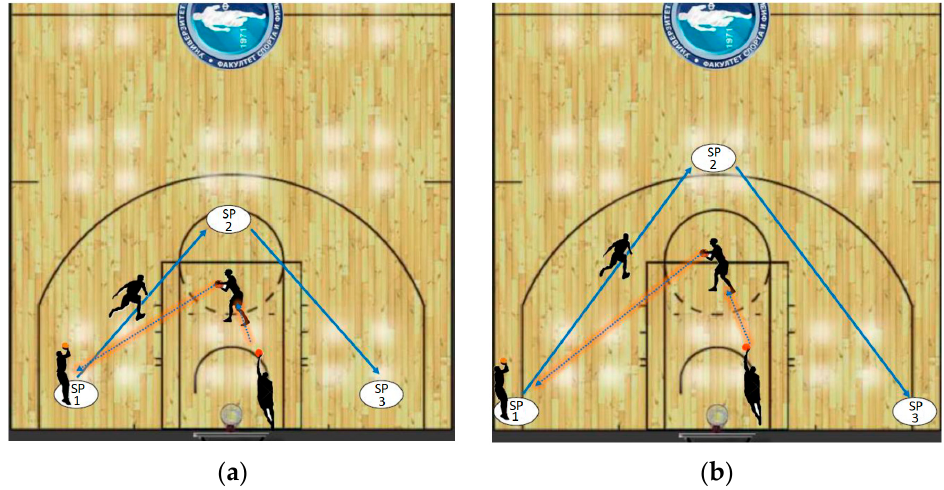
Figure 1. Jump shot assessment, two ‐ points ( a ) and three points ( b ) shooting positions (SP).